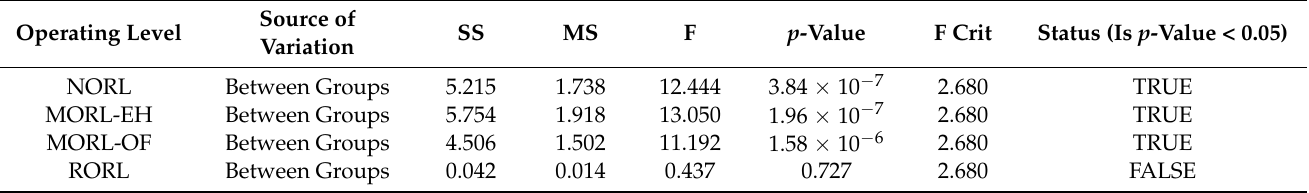
Table 10. Summary of the ANOVA results from the investigated operating water levels (instantaneous, 5 days, 10 days, and 1 m per